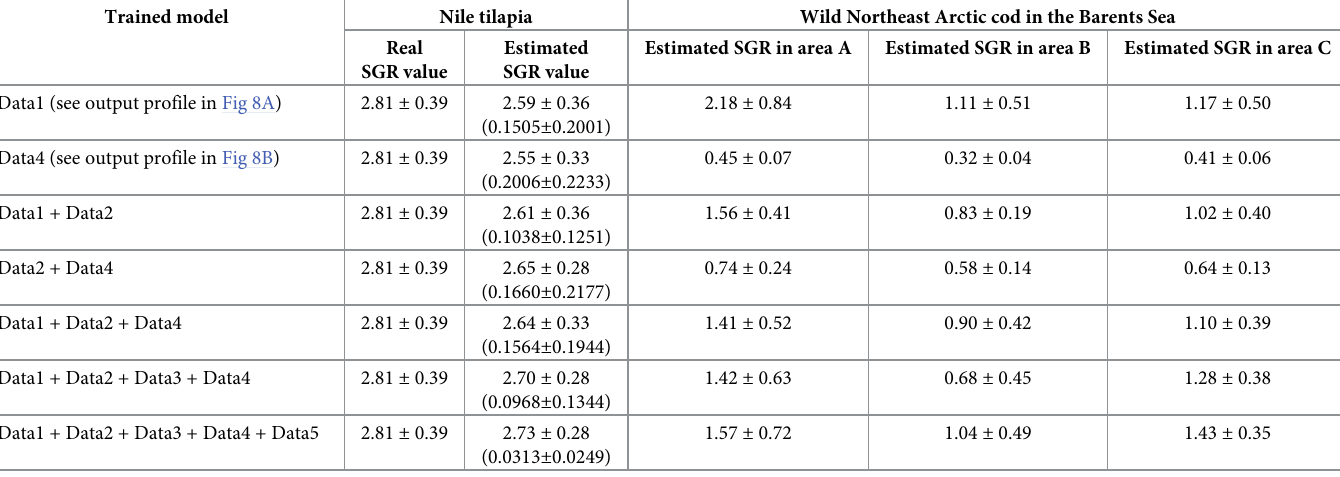
Table 4. Growth estimates of weight specific growth rate (SGR) in % per day (mean ± SD) of Nile tilapia (see Fig 2) and wild Northeast Arctic cod in three different areas of the Barents Sea (see Figs 3 and 4) using different trained models from each dataset and combinations of different datasets with three inputs of normalized weight, normalized activity ratio of trypsin to chymotrypsin (T/C ratio), and normalized condition factor (CF). The values in parentheses are mean squared error (MSE) calculated from the real and estimated SGR values. The network time scale λ = 1.0 for all models (see Table